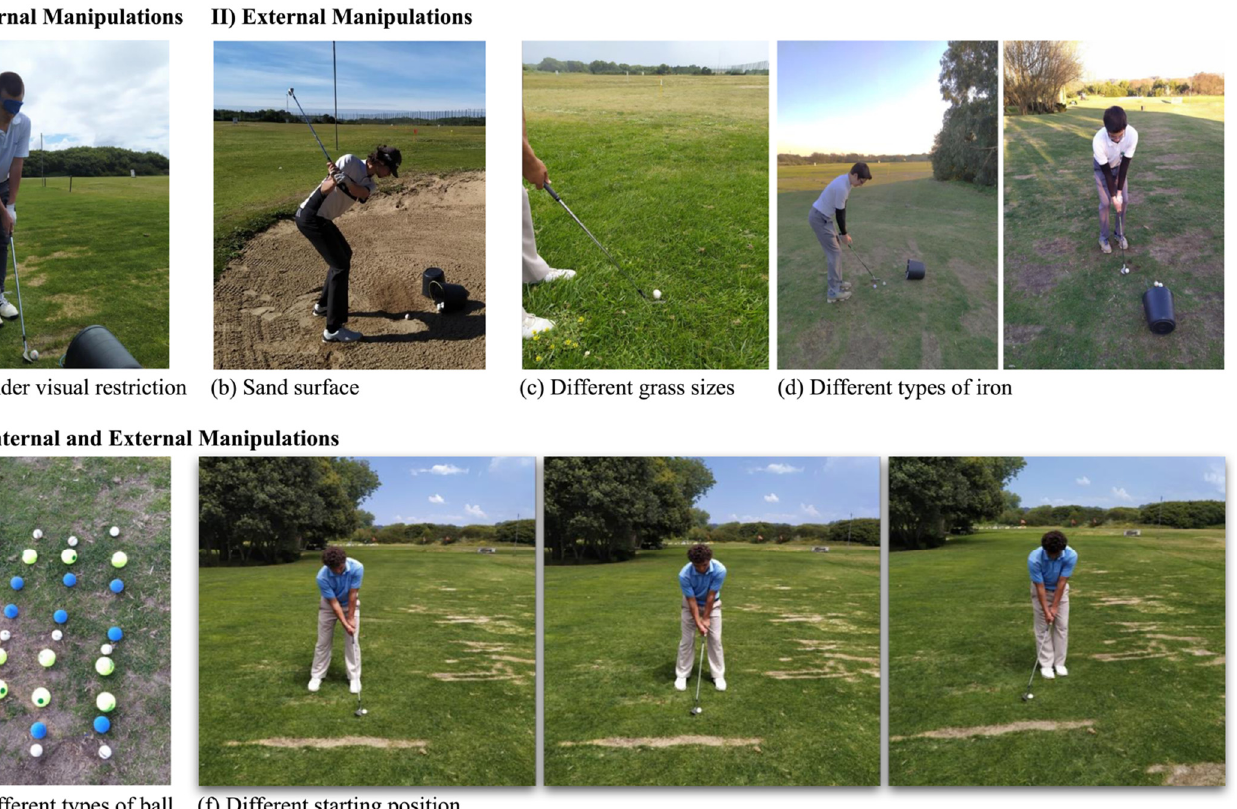
Figure 1. Examples of the fluctuations ( a – f ) enacted to the DL group. Note: ( a ) internal manipulations by performing the golf shot under visual restriction using an eye patch; external manipulations by performing the golf shot in ( b ) different surfaces—sand; ( c ) different grass sizes; ( d ) different types of iron; internal and external manipulations by ( e ) varying the types of ball used; ( f ) different starting